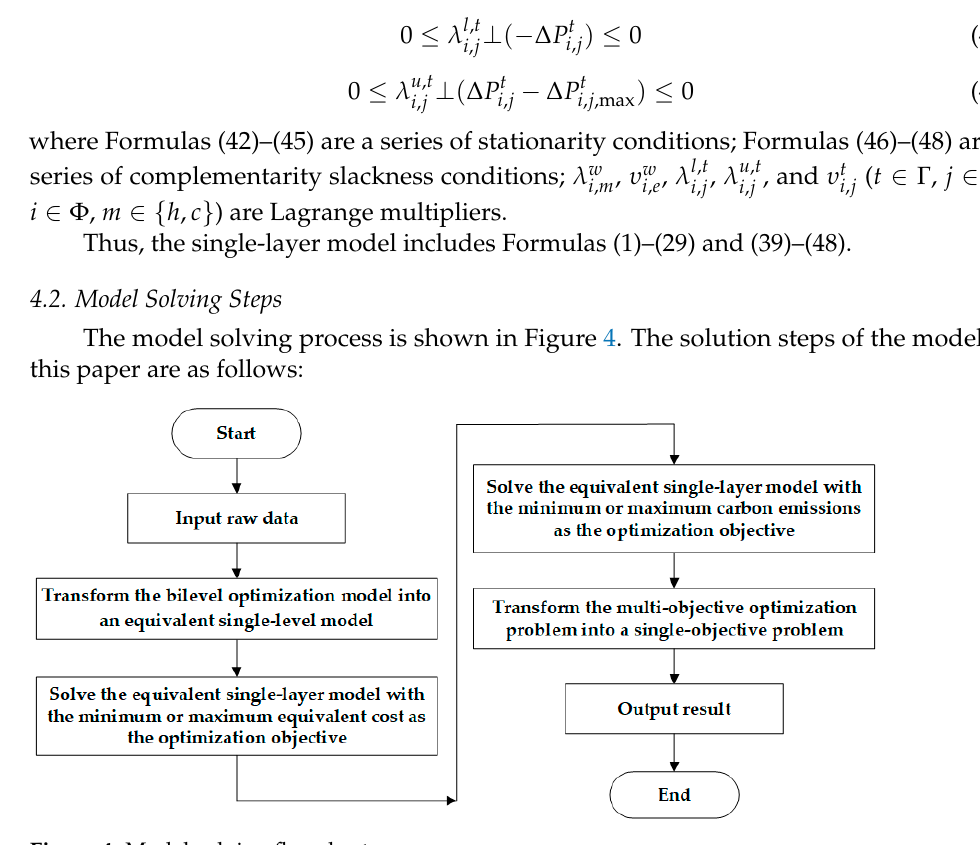
Figure 4. Model solving flowchart.